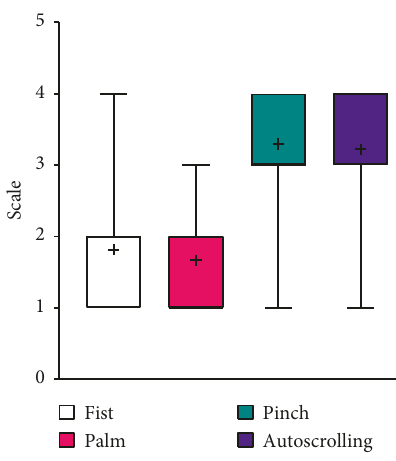
Figure 5: Plot of mean values for participants’